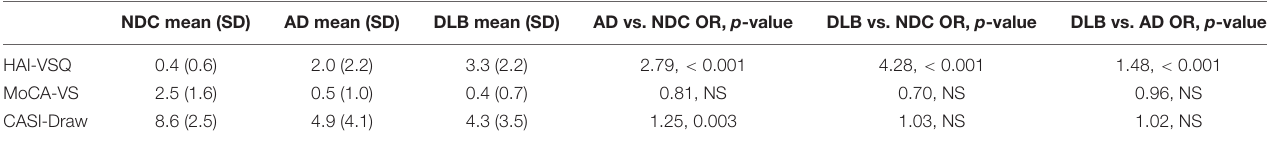
TABLE 3 | Comparison of visuospatial subscales in HAICDDS (HAI-VSQ), MoCA (MoCA-VS), and CASI (CASI-Draw) among NDC ( N = 154), AD ( N = 229), and DLB ( N = 57) participants. NDC mean (SD) AD mean (SD) DLB mean